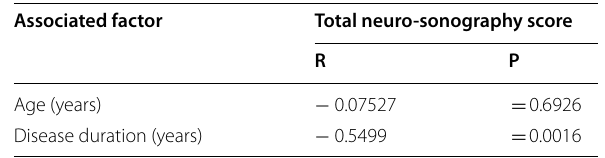
Table 7 Pearson’s correlation analysis for some basic factors associated with total neuro‑sonography score in (cervical group)